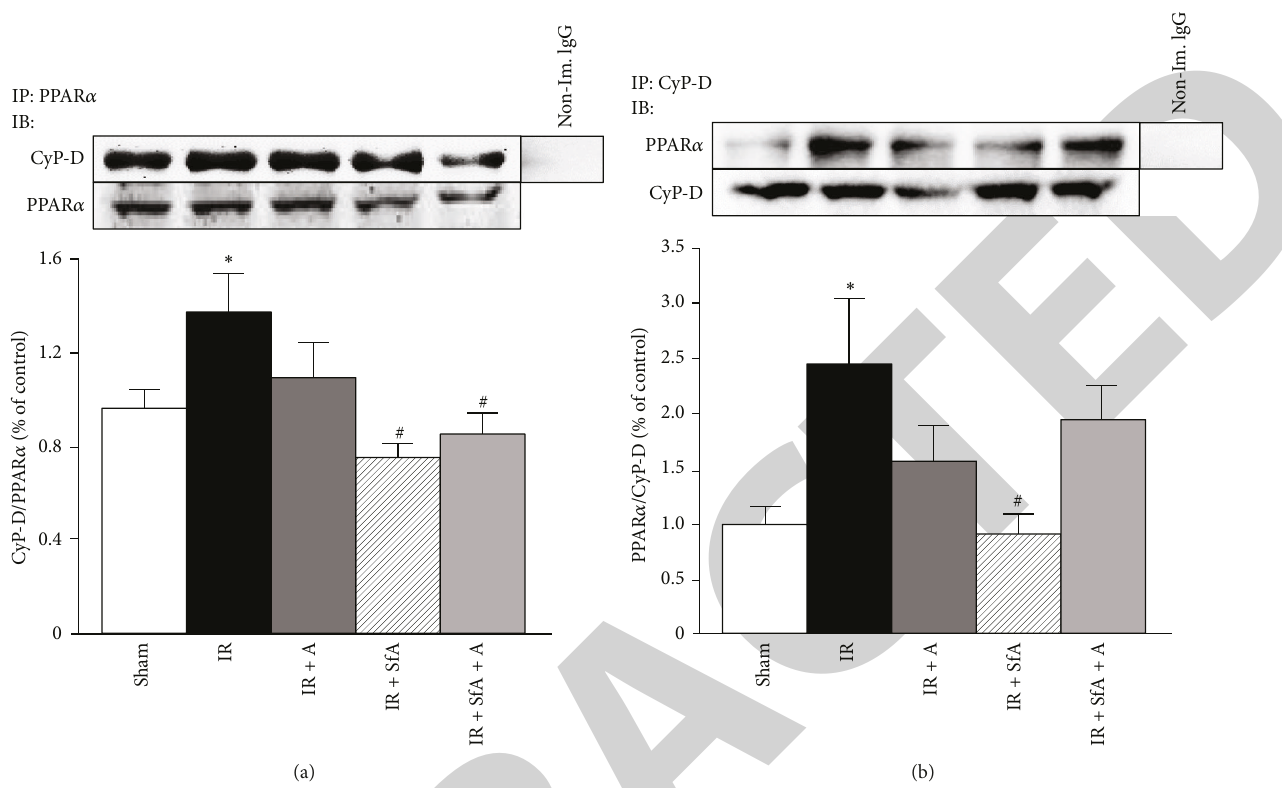
Figure 6: Effects of SfA, A-769662, or their combination on IR-induced CyP-D-PPAR 𝛼 interaction. Isolated mitochondria were immunoprecipitated (IP) with anti-PPAR 𝛼 (a) or anti-CyP-D (b) antibodies. The complexes were subjected to SDS-PAGE, followed by immunoblotting (IB) with CyP-D (a) or PPAR 𝛼 (b) antibodies. Representative immunoblots (a and b, top panels) show the effects of A- 769662 and/or SfA on the interaction between PPAR 𝛼 and CyP-D. Quantitative results (a and b, bottom panels) were expressed as a fold change, compared with Sham. 𝑛 = 3 -4 per each group. ∗ 𝑃 < 0.05 versus Sham; # 𝑃 < 0.05 versus